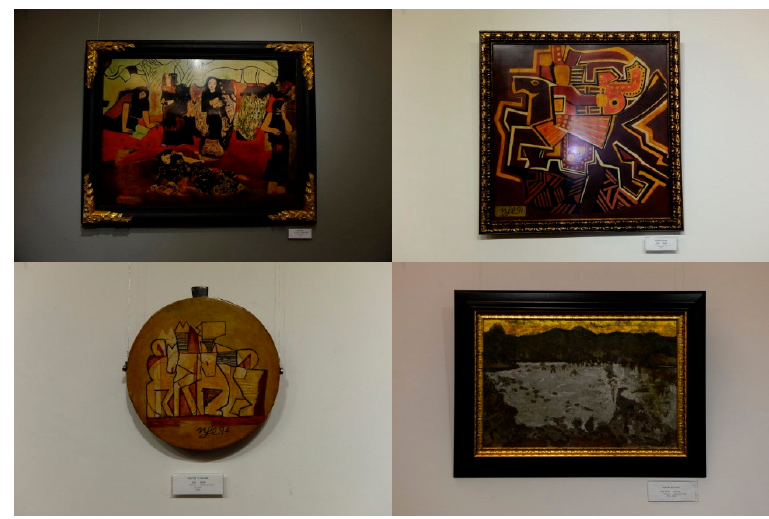
Figure A8. Paintings in Vu Xuan Chung’s collection. The images were sourced from Tuoi Tre Newspaper (Khoa 2016).